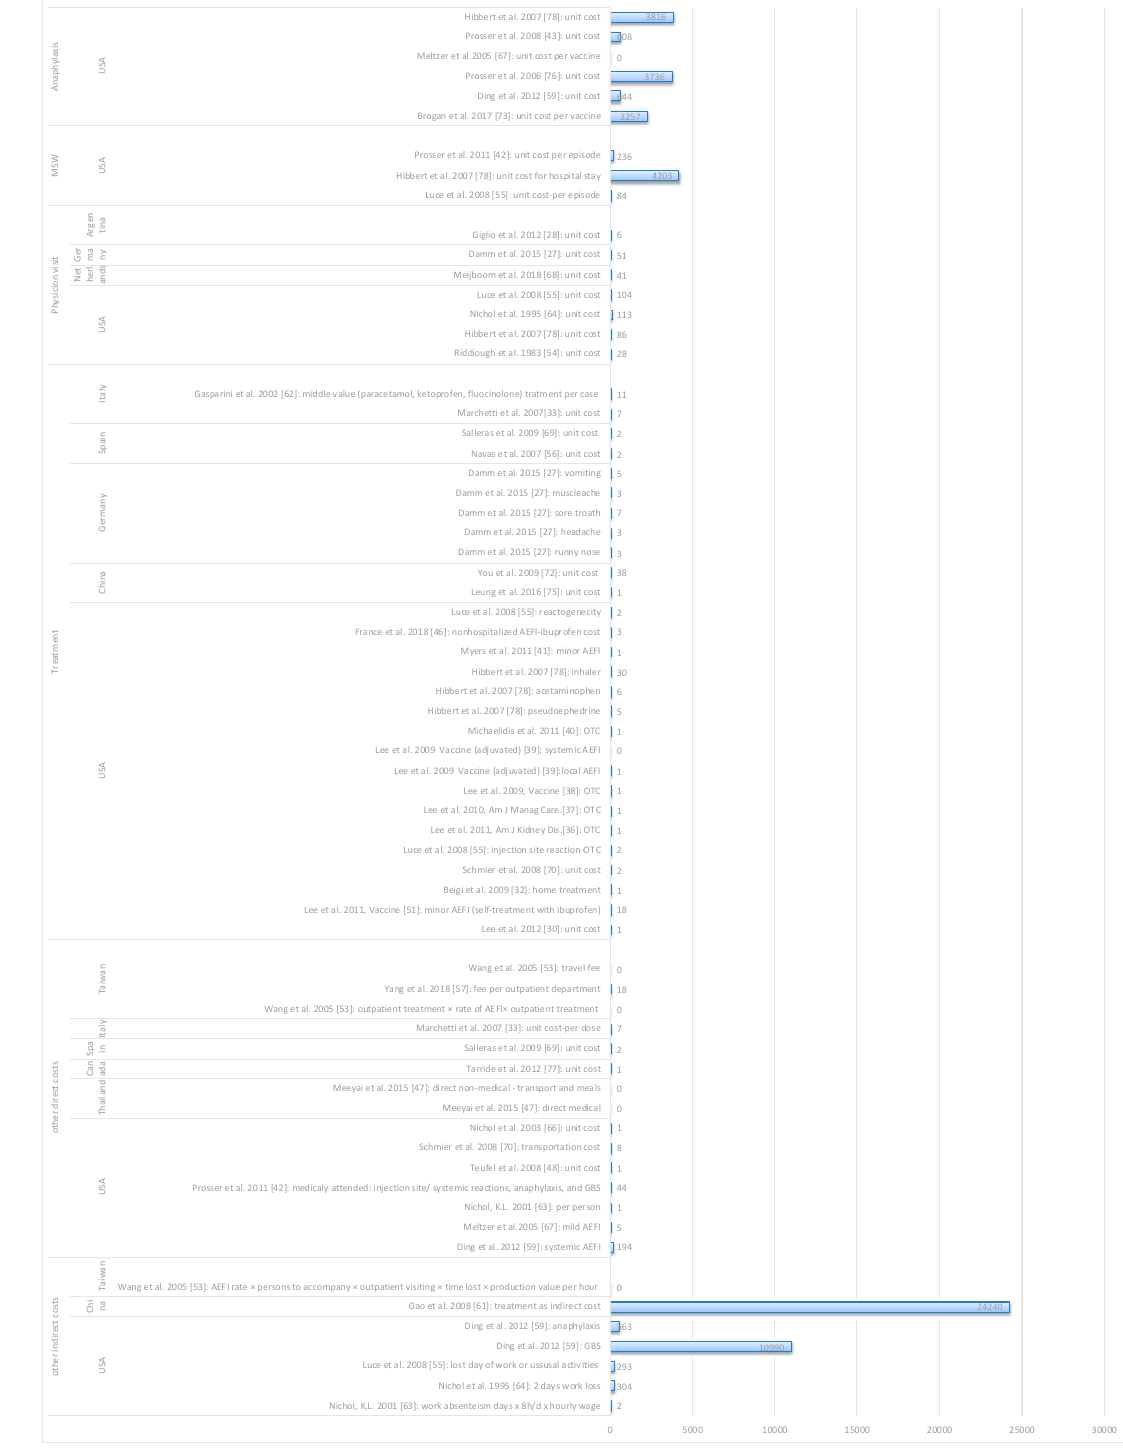
Figure A1. AEFI-related costs. All costs are presented in USD, and 2020 was taken as a reference price year. The cost values under 1 USD are displayed as 0 (Meltzer et al.2005 [67]: anaphylaxis, unit cost per vaccine= 0.01; Lee et al. 2009 Vaccine (adjuvated) [39]: treatment, systemic AEFI= 0.35; Wang et al. 2005 [53]: other direct costs, travel fee= 0.02; Wang et al. 2005 [53]: other direct costs, outpatient treatment × rate of AEFI × outpatient treatment= 0.15; Meeyai et al. 2015 [47]: other direct costs, direct non-medical - transport and meals= 0.18; Meeyai et al. 2015 [47]:other direct costs, direct medical= 0.02; Wang et al. 2005 [53]: other indirect costs, AEFI rate × persons to accompany × outpatient visiting × time lost × production value per hour= 0.15).